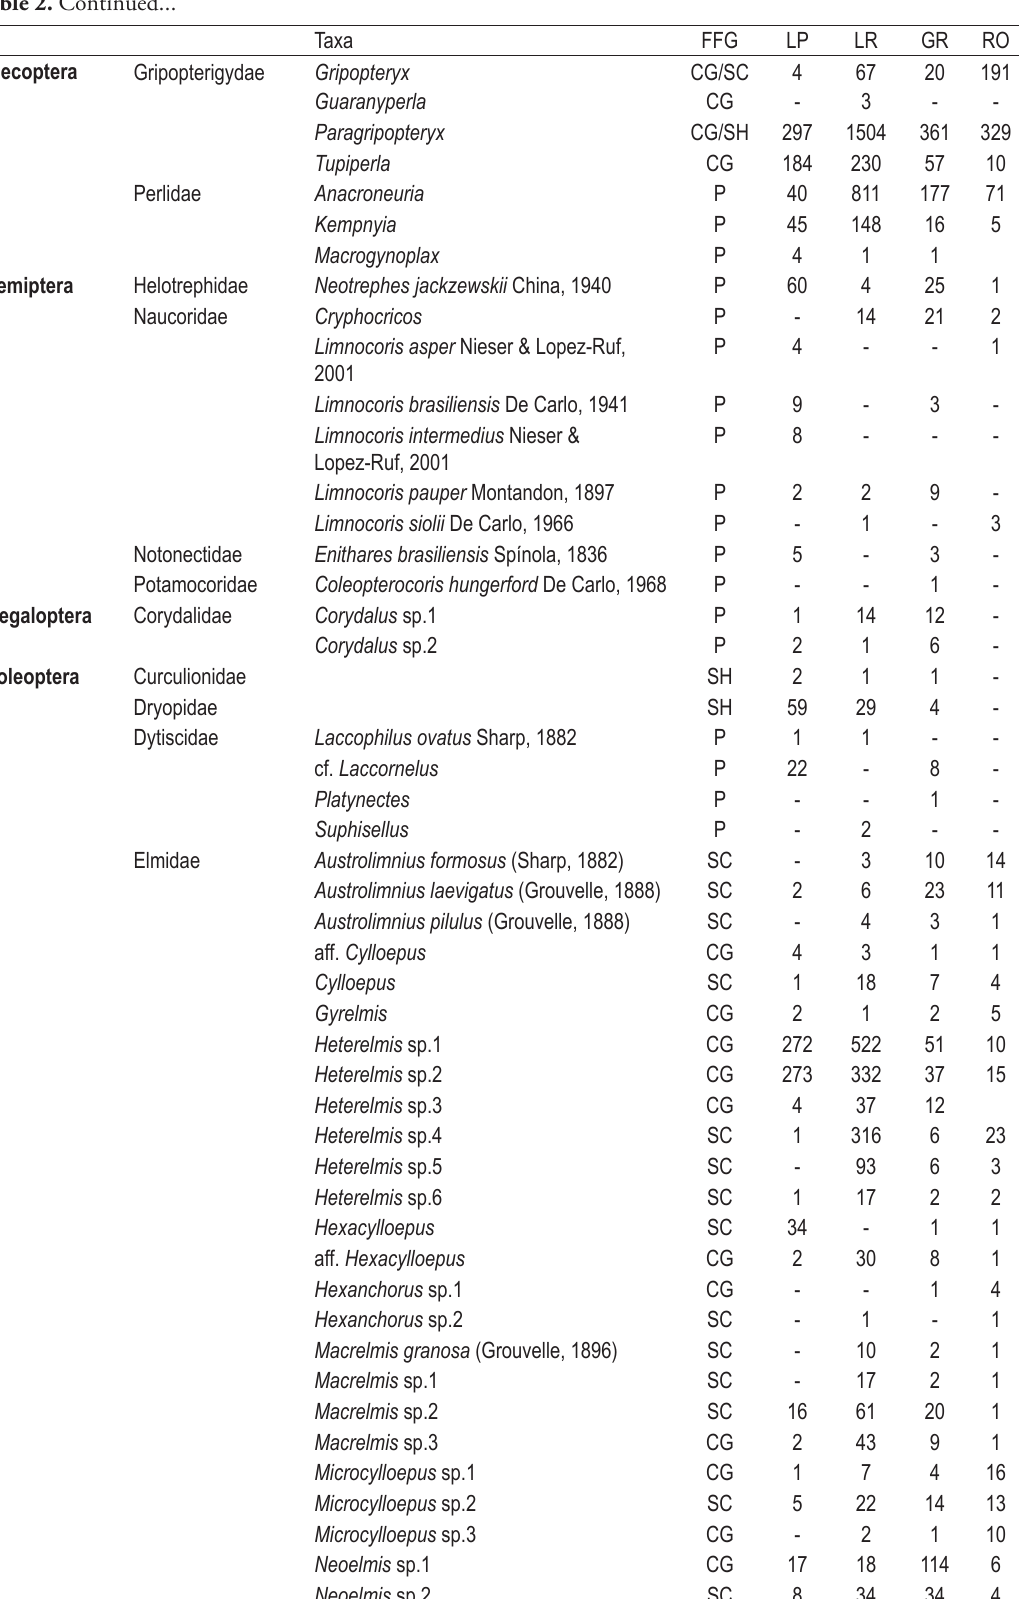
LP = litter from pool, LR = litter from riffle, GR = gravel and RO = rocks. CG = collector-gatherers, CF = collector- filterers, SC = scrapers, SH = shredders, P =